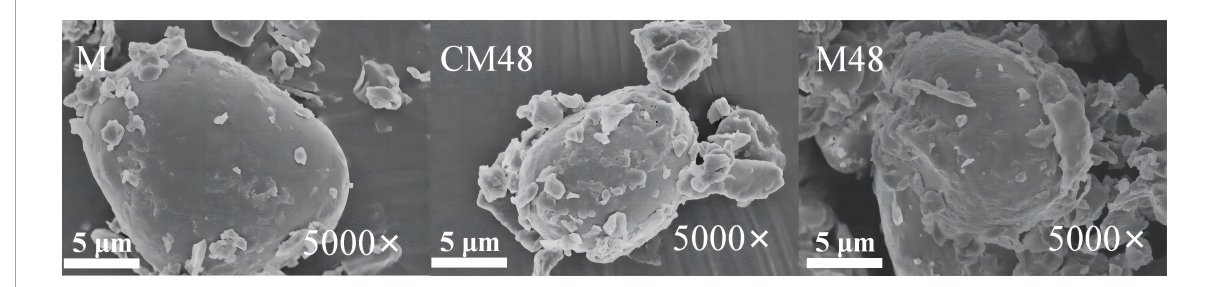
FIGURE3 Scanning electron microscopy (SEM) images of the ungerminated and germinated mung beans. M, ungerminated mung bean; CM48, mung bean germinated for 48 h; M48, mung bean pretreated with a combination of ultrasonic and γ -aminobutyric acid (GABA) and germinated for 48 h.